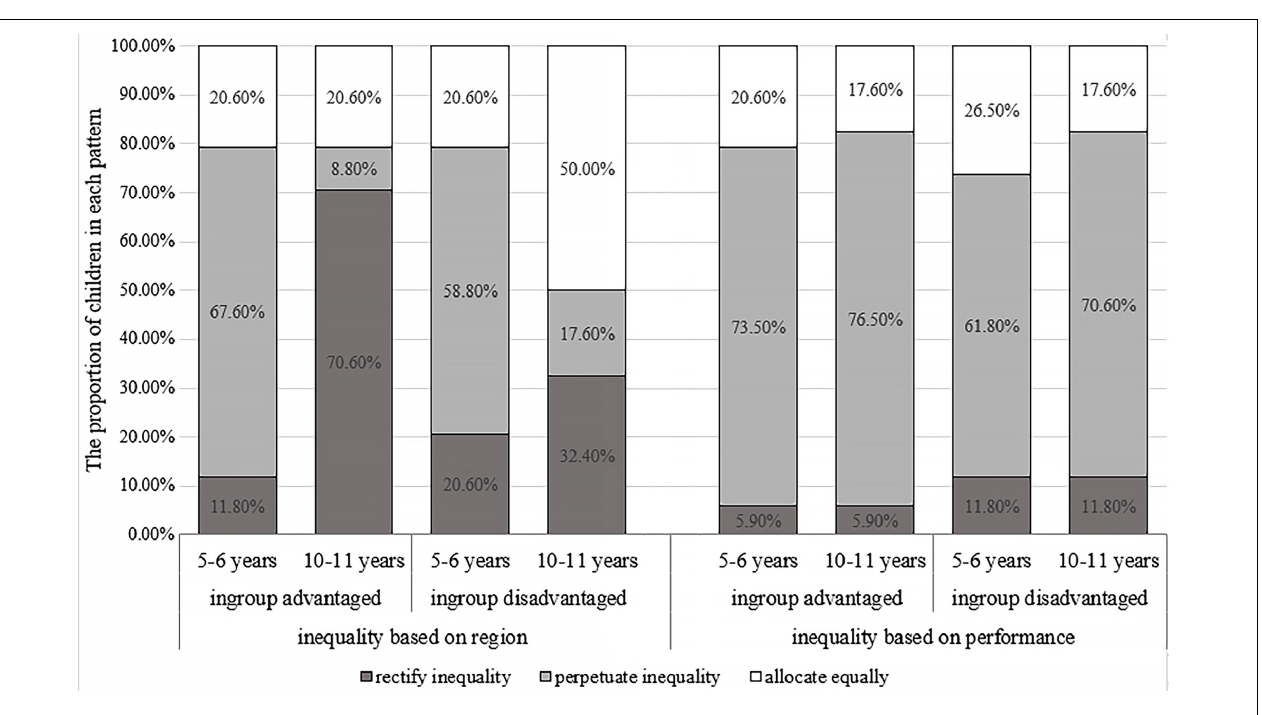
FIGURE 4 | Percentage of allocation patterns between groups in experiment